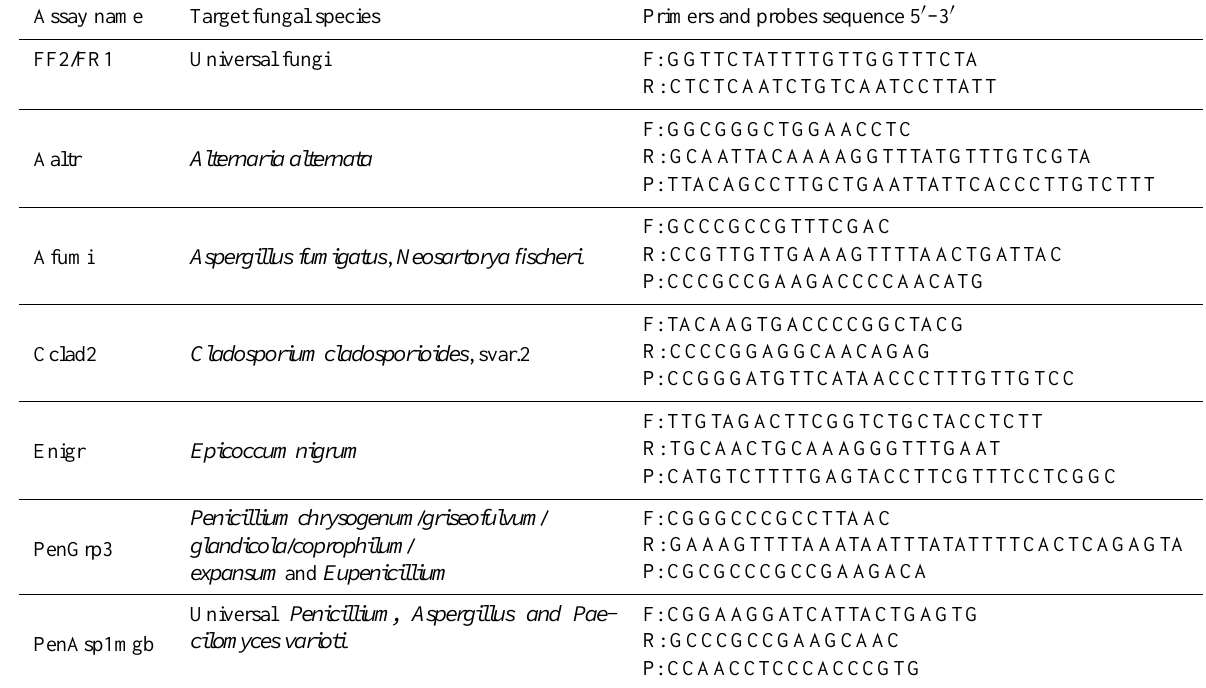
Table 1. The qPCR assays as detailed in Zhou et al. (2000) and Haugland (2002). Assay